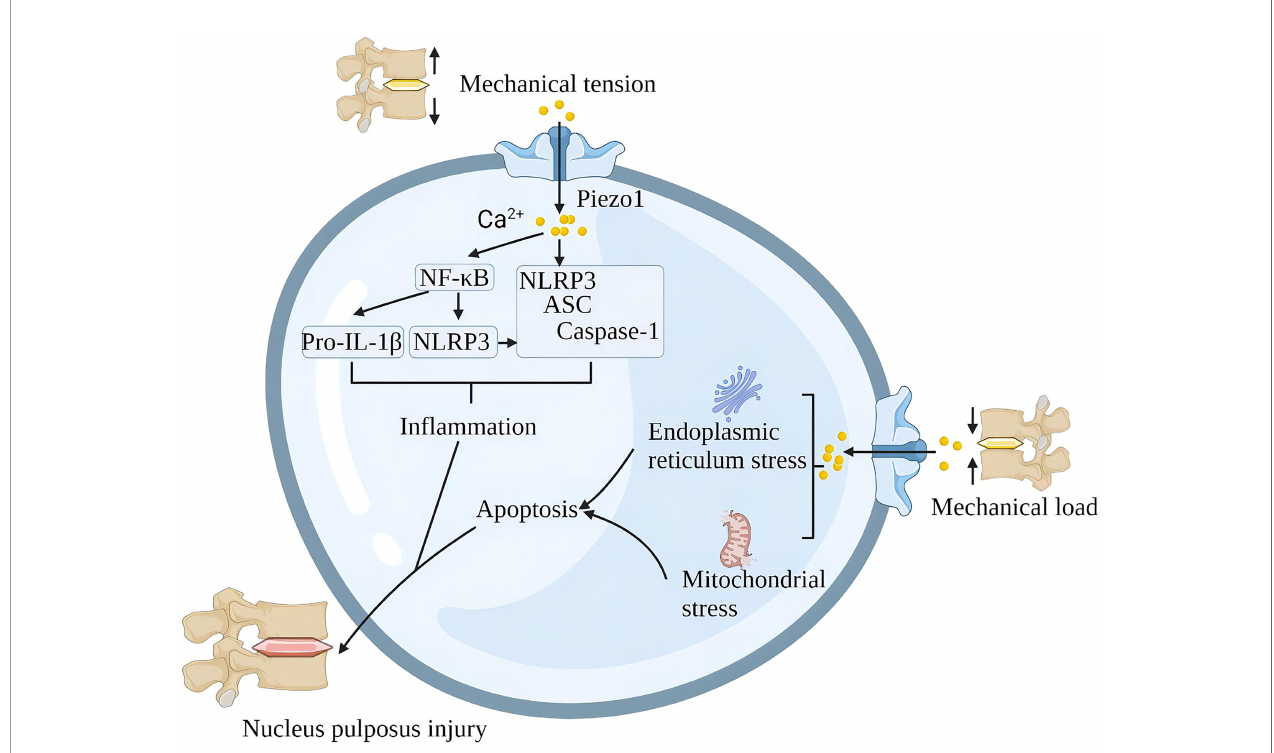
FIGURE 9 | Schematic diagram of the role of Piezo1 in spinal degeneration. Piezo1 on the nucleus pulposus cells senses mechanical stretching and induces Ca 2+ in fl ux, which initiates the in fl ammatory pathways of NF- k B and NLRP3. Mechanical shock induces mitochondria and endoplasmic reticulum stress through Piezo1, leading to apoptosis of nucleus pulposus cells. Chronic in fl ammation and loss of nucleus pulposus cells lead to spinal